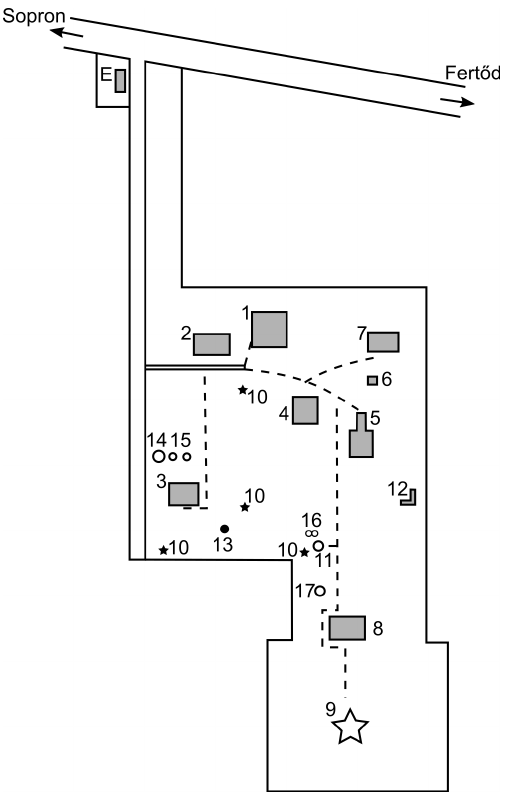
Figure 2. Observatory site diagram. E – entrance; 1 – main building with staff hostel and electronic laboratory; 2 – telluric instruments and office; 3 – atmospheric-electricity house (laboratory of Schu- mann resonance, potential gradient, point discharge, and radio wave absorption measurements); 4 – magnetic absolute house with four pillars; 5 – underground magnetic variometer chambers; 6 – proton magnetometer hut; 7 – computer centre (data loggers, local-network server, and satellite transmitter); 8 – ionosonde station, electric, and mechanical workshop; 9 – ionosonde D antenna; 10 – ionosonde re- ceivers; 11 – meteorological station; 12 – ELF induction coil cham- ber; 13 – ball antenna (Schumann resonance antenna); 14 – poten- tial gradient sensor (stationary field mill); 15 – potential gradient sensors (radioactive); 16 – SAR reflector; 17 – VLF antenna. The figure is adopted and modified from Wesztergom